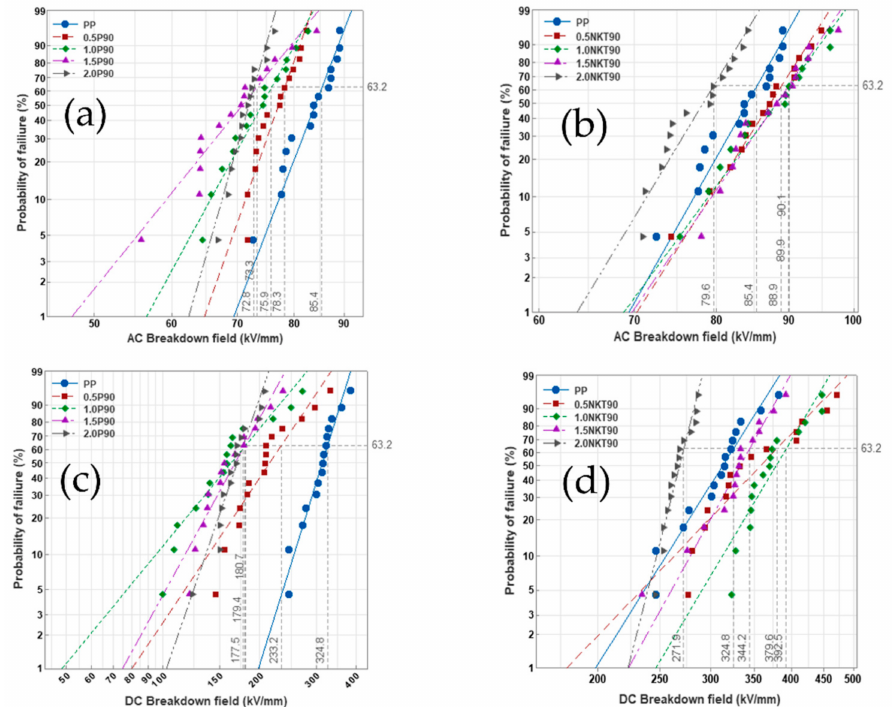
Figure 8. AC/DC electrical breakdown results of PP blends. ( a ) AC breakdown strength results of P90 composites; ( b ) AC breakdown strength results of NKT90 composites; ( c ) DC breakdown strength results of P90 composites; ( d ) DC breakdown strength results of NKT90